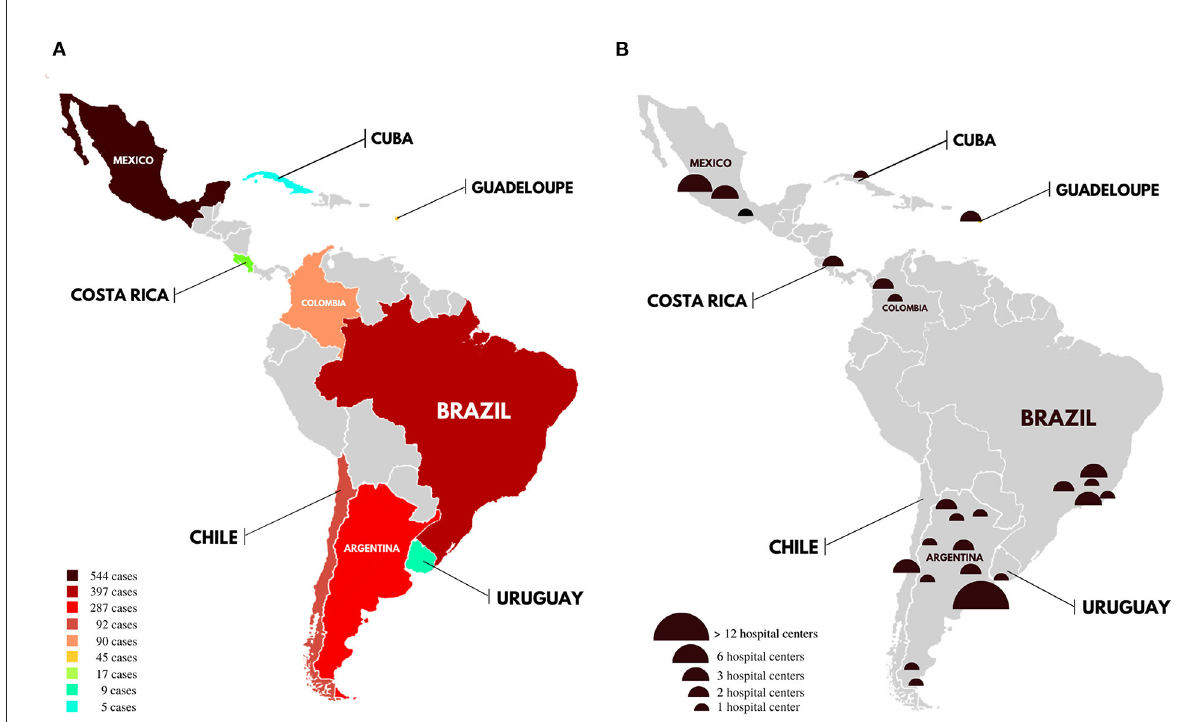
FIGURE2 (A) Distribution of CVT studies in Latin America. The map shows the reported CVT cases in large series ( ≥ 5 patients) by country until July 2022. (B) Distribution of CVT database centers in Latin America. The map shows only specified centers in large series ( ≥ 5 patients) in each country until July